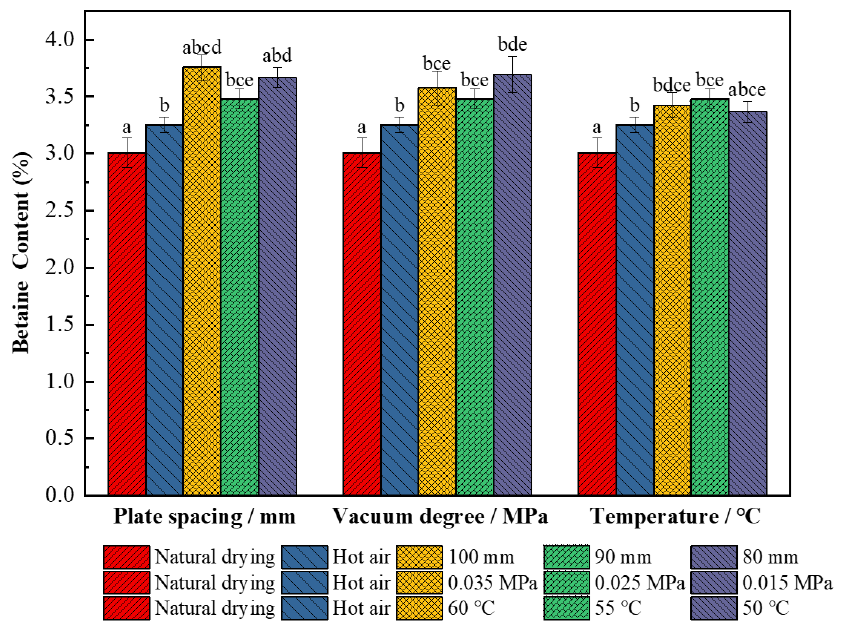
Figure 10. Betaine content of L. barbarum under different drying conditions. Significant differences are represented by different letters ( p < 0.05).